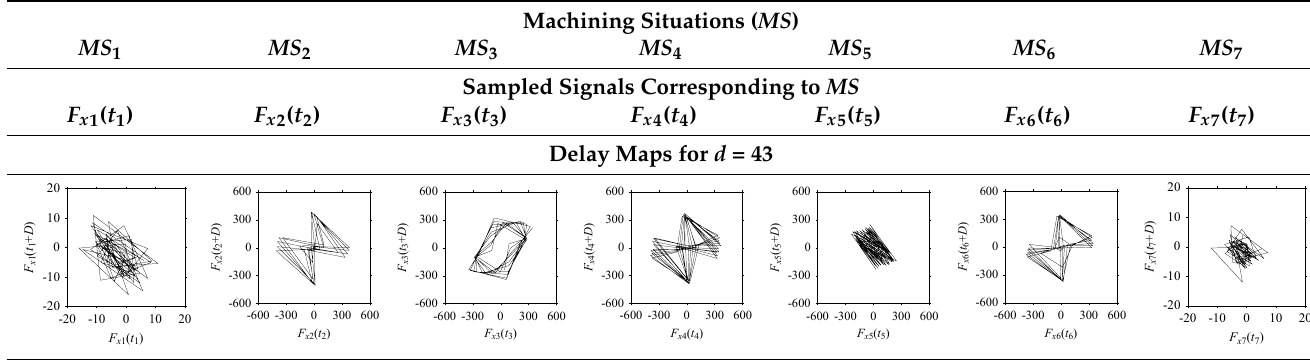
Table 6. Delay maps for F x 1 ( t 1 ),…, F x 7 ( t 7 ) (corresponds to MS 1 ,…, MS 7 ) when d = 43. Machining Situations ( MS ) Sampled Signals Corresponding to MS